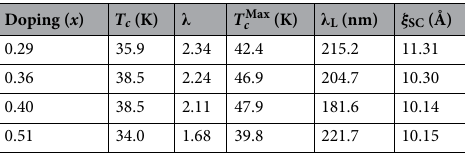
Table 1. Doping-dependent SC physical quantities of K-doped Ba-122 (Ba 1